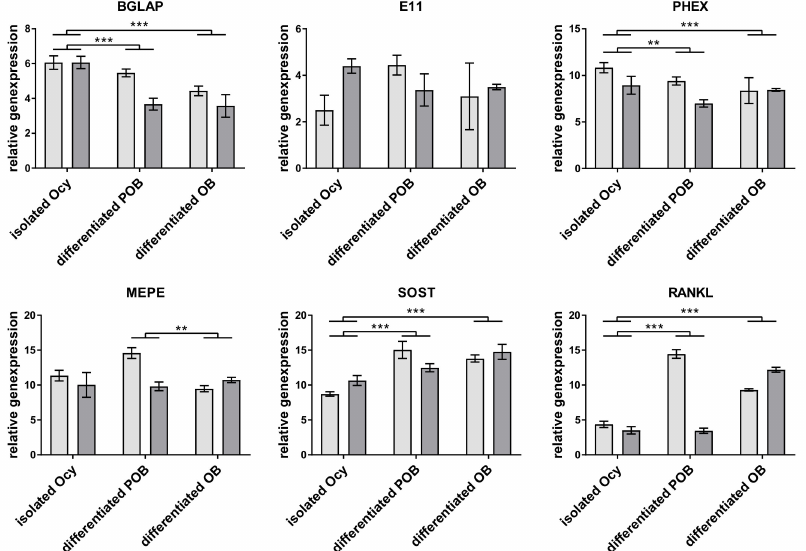
Figure 2. Relative expression of osteocyte-specific genes from isolated and in vitro di ff erentiated osteocytes. Diagrams show the ∆ Ct value in relation to the expression of glyceraldehyde-3-phosphate dehydrogenase (GAPDH). Data from two di ff erent cell donors are presented in one diagram ( n = 3 replicates / donor): mean ± sd. Significant di ff erences were defined as * p < 0.05, ** p < 0.01, and *** p < 0.001 (two-way